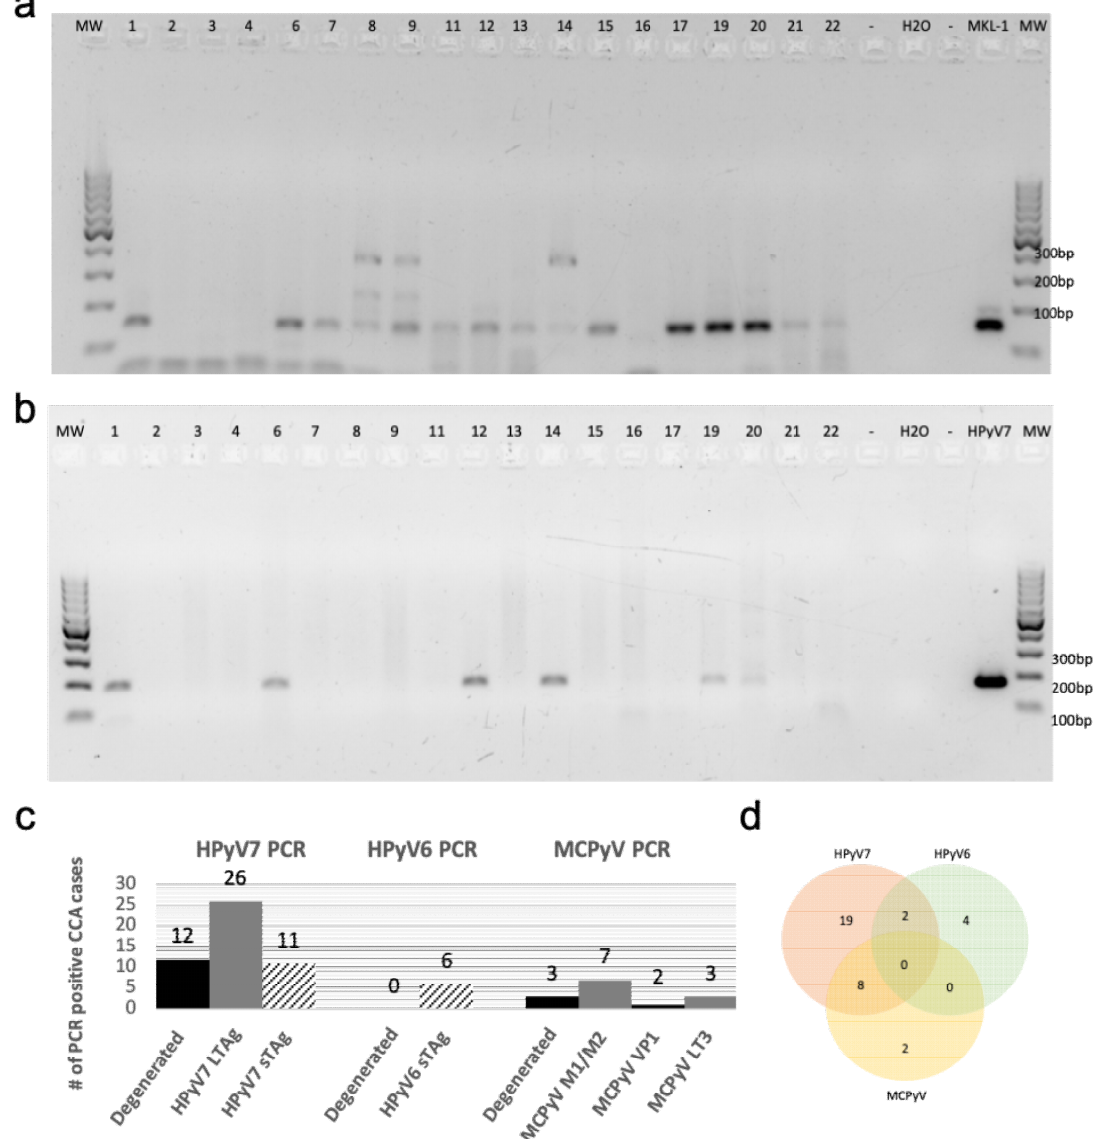
Figure 1. Degenerated and specific HPyV7 DNA-PCR. ( a ) The results of screening for HPyVs using FFPE tissues of Cholangiocarcinoma (CCA) by performing degenerated PCR-DNA. ( b ) Specific DNA-PCR amplifying HPyV7 sTAg (181 bp). ( c ) A chart summarizing the total HPyV results for both degenerated and specific DNA-PCR. The numbers on the gels refer to the number of CCA tissues of the respective CCA patients. ( d ) Venn diagram showing cases with two di ff erent HPyVs simultaneously. Abbreviations: Numbers on gels: represents the patient ID; H 2 O: water non-template negative control; MKL-1: MCPyV-positive Merkel cell carcinoma cell line used as a positive control; empty slot (no mastermix added to the gel); MW: molecular weight